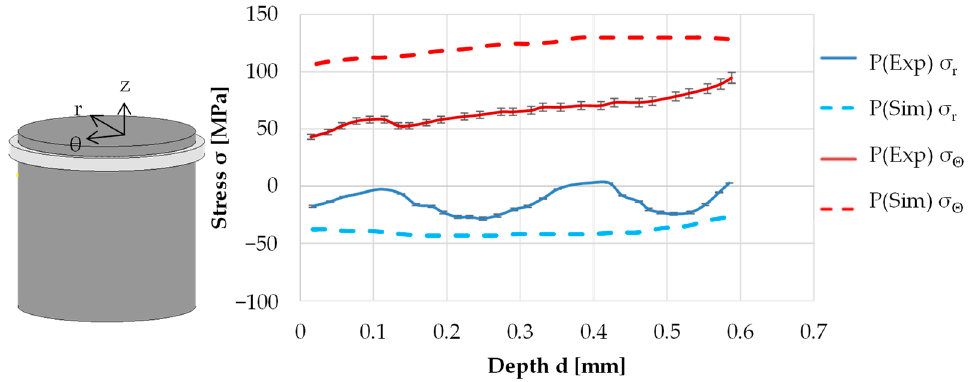
Figure 18. Position of the residual stress measurement point in hole drilling experiment ( a ) and numerical analysis ( b ).